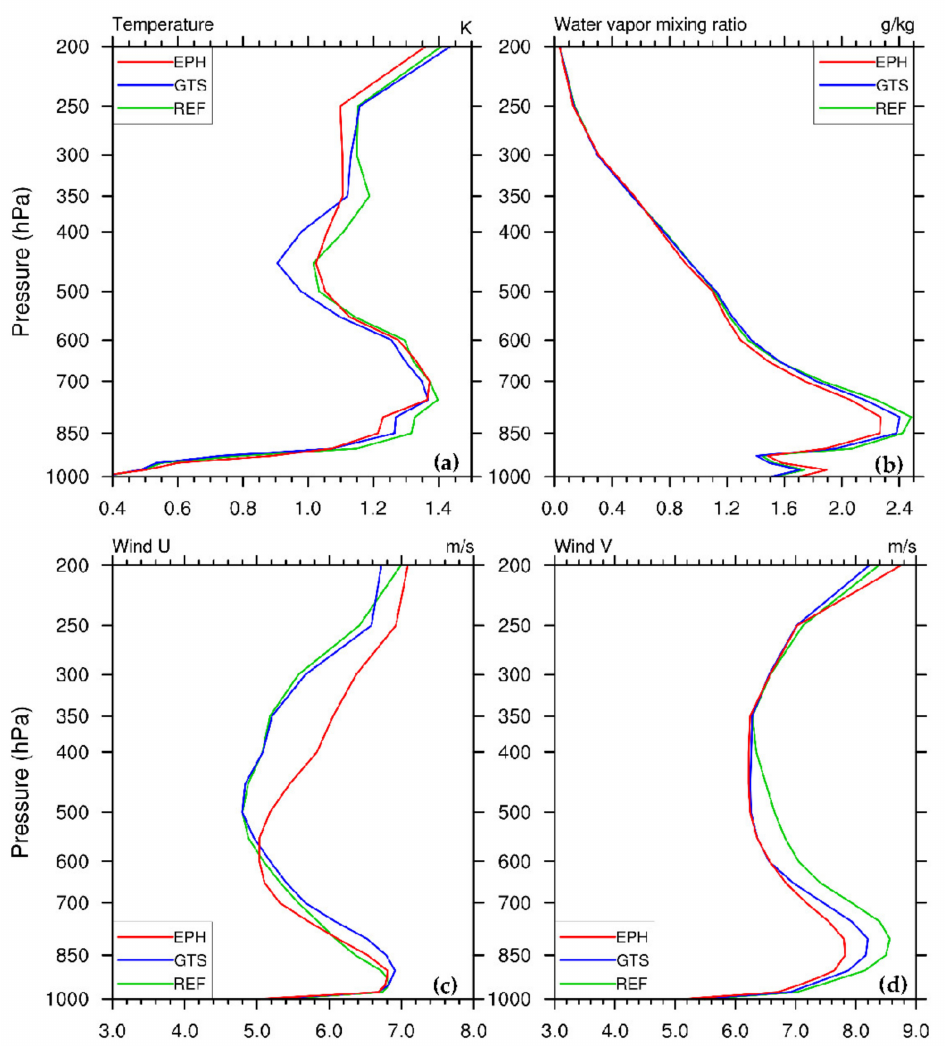
Figure 9. The RMSE of the model forecast for the experiments EPH (red), GTS (blue), and REF (green) verified against the NCEP analysis over 10–30 ◦ N, and 130–160 ◦ E, for ( a ) temperature (K), ( b ) water vapor mixing ratio (g kg − 1 ), ( c ) east–west wind component ( u ), and ( d ) north–south wind component ( v ), at 48-h forecast (1200 UTC 4 September